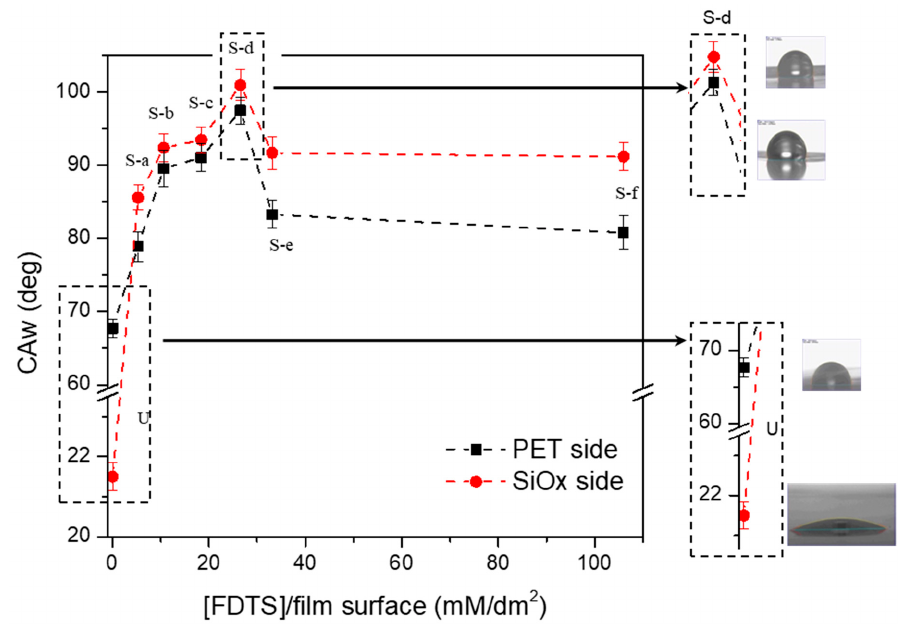
Figure 5. Effect of the reaction conditions on the water contact angles (CAw) of the films: black square marks indicate the uncoated PET side, and the red circle marks indicate the SiOx-coated side.